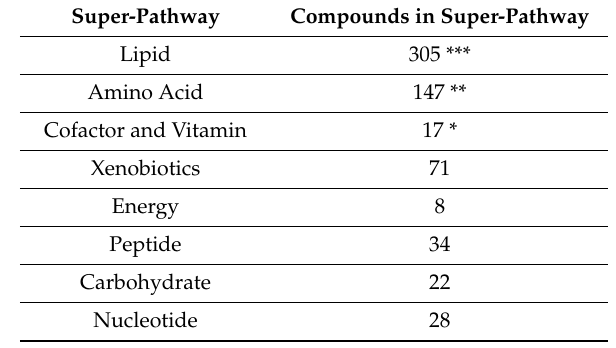
Table 2. Super-pathways analysis on metabolite perturbations detected in Rett syndrome.